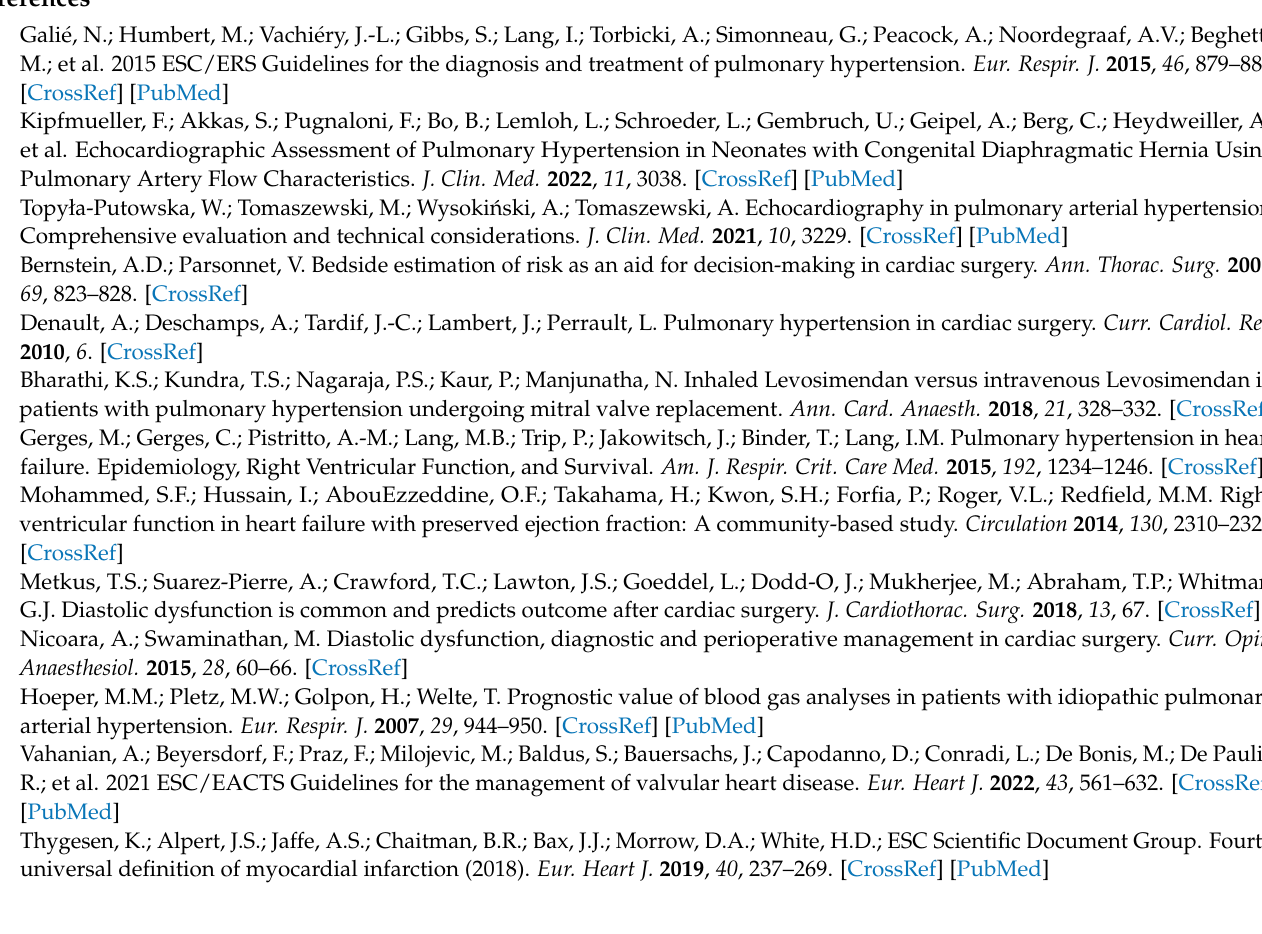
Figure A3. Inferior vena cava inspiratory diameter—four chamber subcostal view.